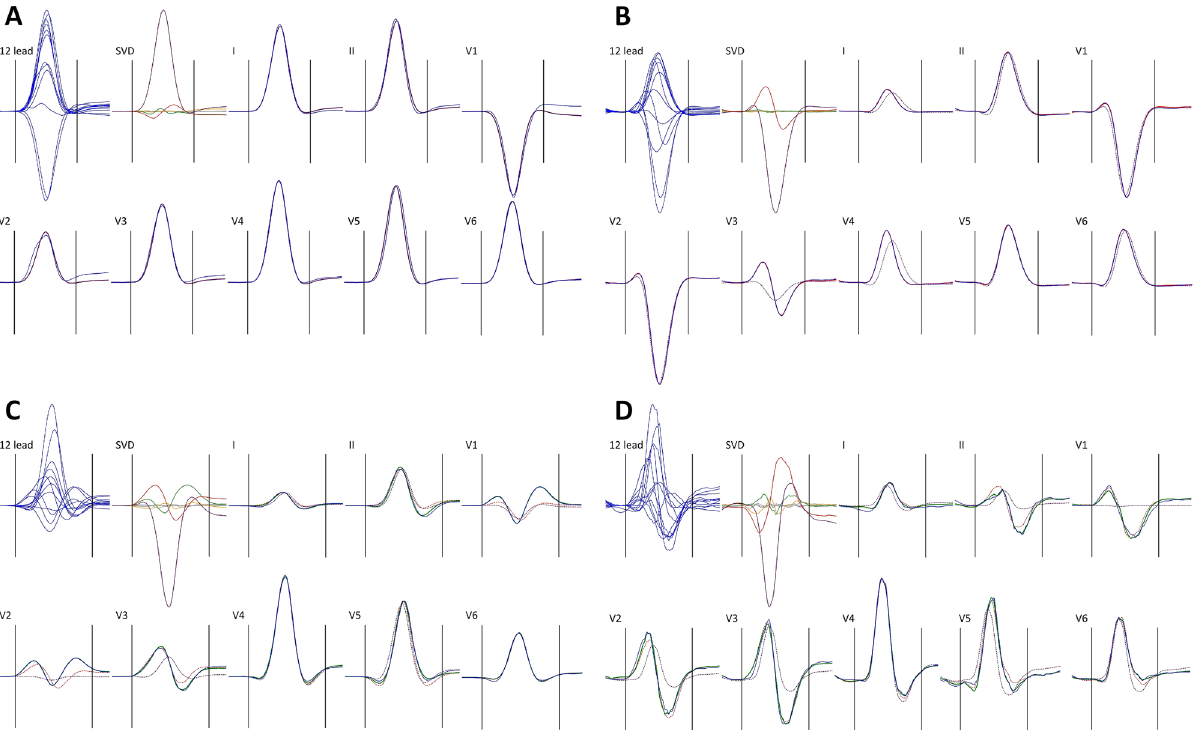
Figure 1. Examples of QRS reconstruction by orthogonal components. In all panels, superimposition of all 12 leads of the filtered representative median image of the QRS complex (12 lead) is shown together with the orthogonal components of matrix W (SVD) and with individual independent leads (I, II, V1, V2, …, V6) superimposed with the reconstruction. In all panels, the original ECG waveforms are shown in blue, the first, second, third, and fourth orthogonal components in violet, red, green, and amber, respectively (with all further components shown in grey). Panel ( A ) shows an ECG of a 51-year old female in which the reconstruction by the first component (full violet lines in the images of individual leads) explained 91.15% of the QRS area. Panel ( B ) shows an ECG of a 22-year old female in which the reconstruction by the first component (dotted violet lines in the lead images) explained 73.46% of the QRS area but the combination of the first and second component (full red lines in the lead images) explained 97.93% of the QRS area. Panel ( C ) shows an ECG of a 28-year old male in which the first and first + second component (dotted violet and red lines in the lead images, respectively) explained 58.49% and 72.56% of the QRS area but in which the combination of the first 3 components (full green lines in the lead images) explained 93.17% of the QRS area. Panel ( D ) shows an ECG of a 37-year old